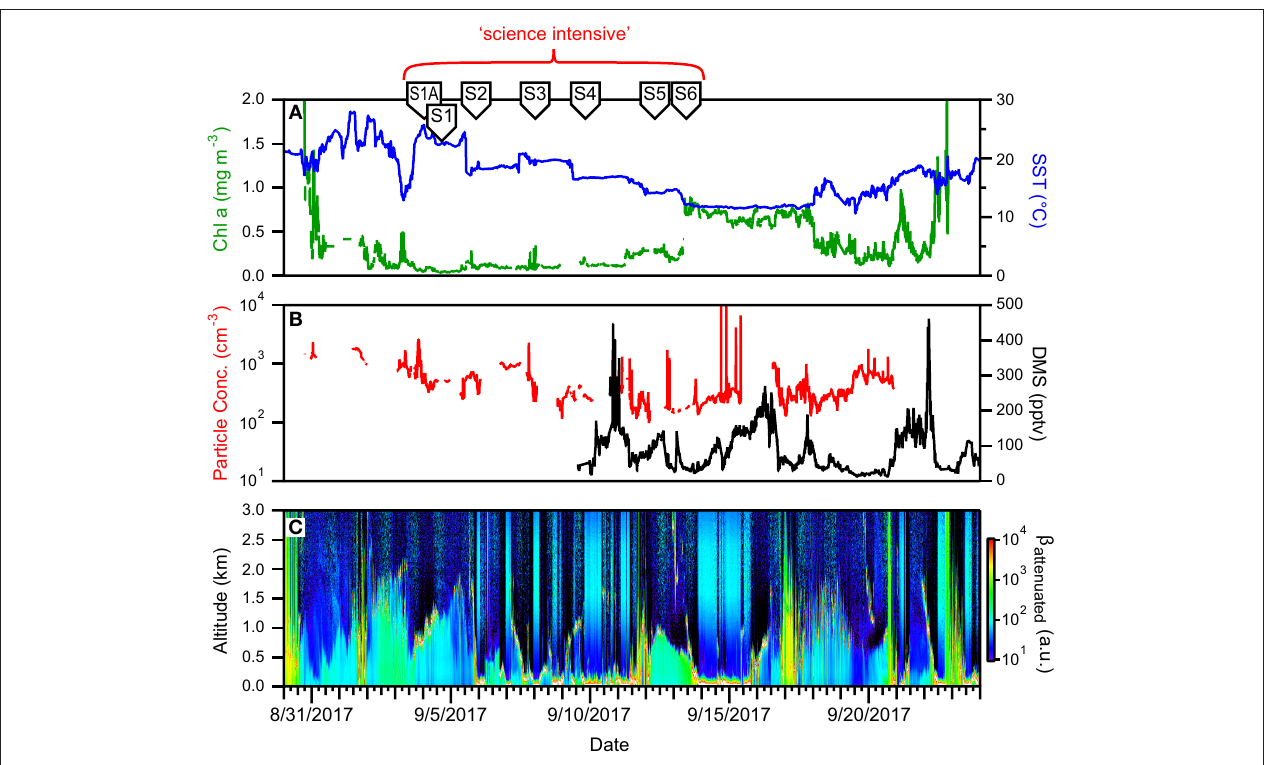
FIGURE 12 | Ocean and atmosphere properties as a function of campaign date during NAAMES 3. (A) Surface chlorophyll concentration (green line) and sea surface temperature (SST; blue line) as a function of hours along ship transit. (B) Particle number concentration (red line) and dimethylsulfide gas mixing ratio (black line) along the ship transit. (C) Attenuated backscatter curtain in arbitrary units as detected by the ship-based ceilometer along the ship transit. The record begins on 8/30/2017 at 41 ◦ 9 ′ N, 70 ◦ 54 ′ W on the outbound transit and ends on 9/24/2017 at 41 ◦ 25 ′ N, 66 ◦ 59 ′ W on the return transit. Red bracket = “science intensive” segment of transit. Labeled symbols at top of panel indicate ship location at the beginning of each primary station (S1A–S6).